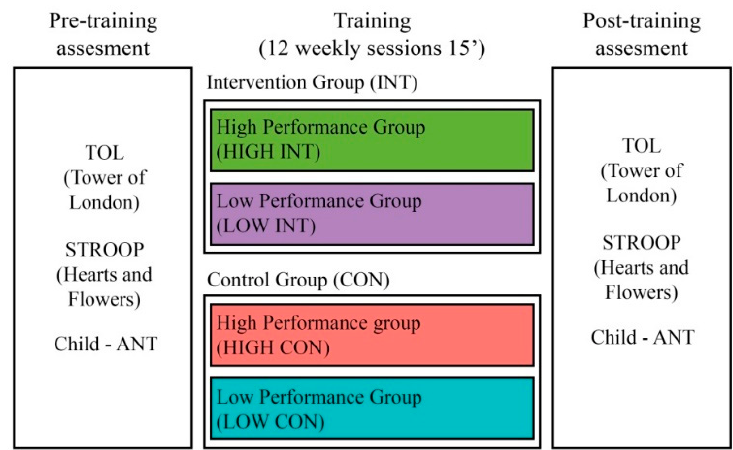
Figure 1. Study design. Note. TOL = Tower of London task, STROOP = Stroop Task, Child-ANT = Attentional Networks Tasks, INT = Intervention group, CON = Control group.